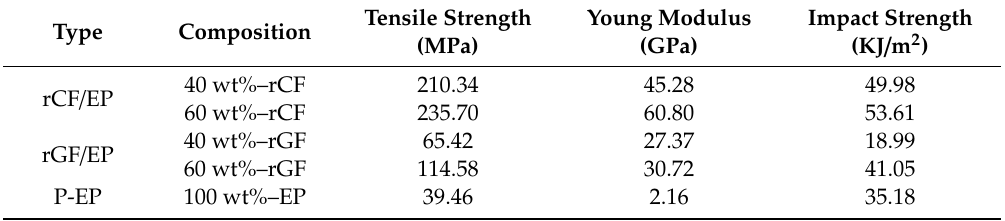
Table 2. Measured values of the remanufactured composites.